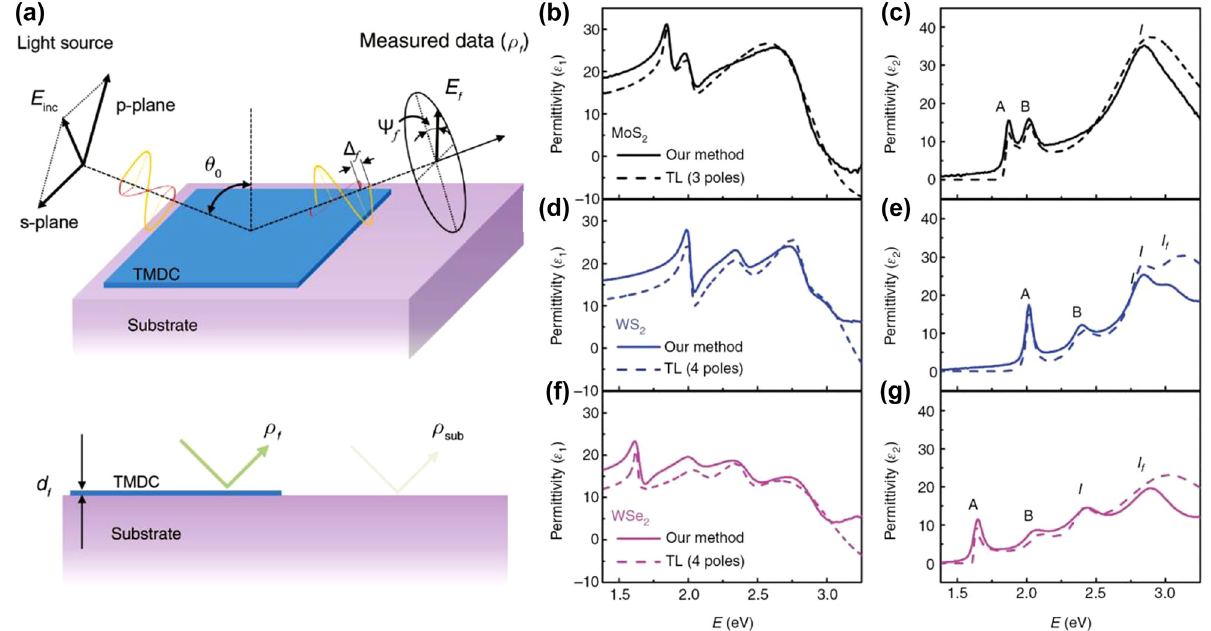
Figure 6: Deterministic ellipsometry for 2D materials. (a) Schematic of the deterministic ellipsometry for 2D materials. Comparison of the permittivity ε = ε 1 + i ε 2 obtained by the deterministic ellipsometry (solid lines) and conventional spectroscopic ellipsometry with few TL oscillators (dashed lines) for (b and c) monolayer MoS 2 , (d and e) WS 2 , and (f and g) WSe 2 . Reprinted with permission from Ref. [30], copyright 2018, de